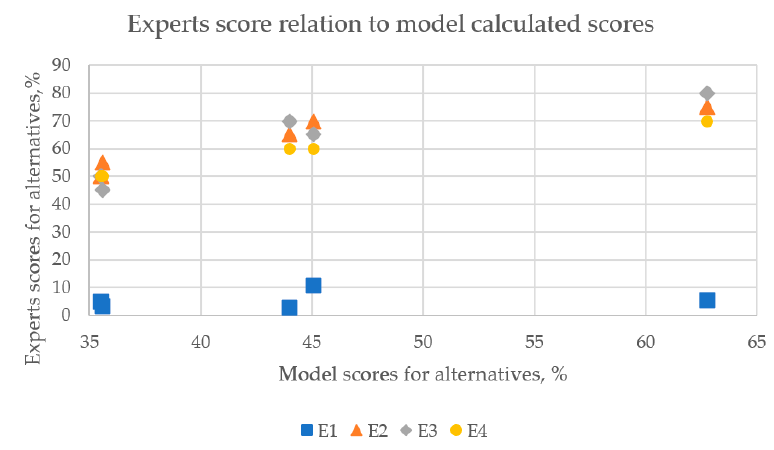
Figure 5. Experts score relation to model calculated security score. Table 7. Correlation between model results and experts’ opinions.